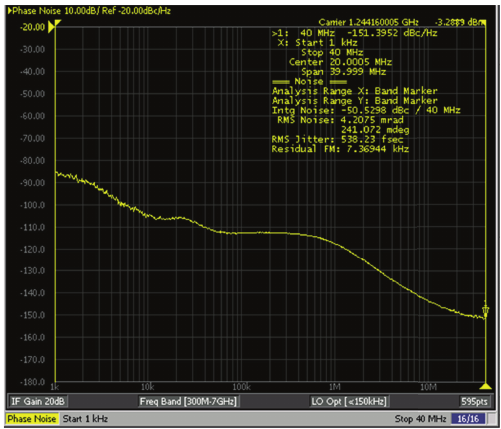
Figure 10: Closed-loop phase noise and RMS jitter measurement at 1.244 GHz output (F 40